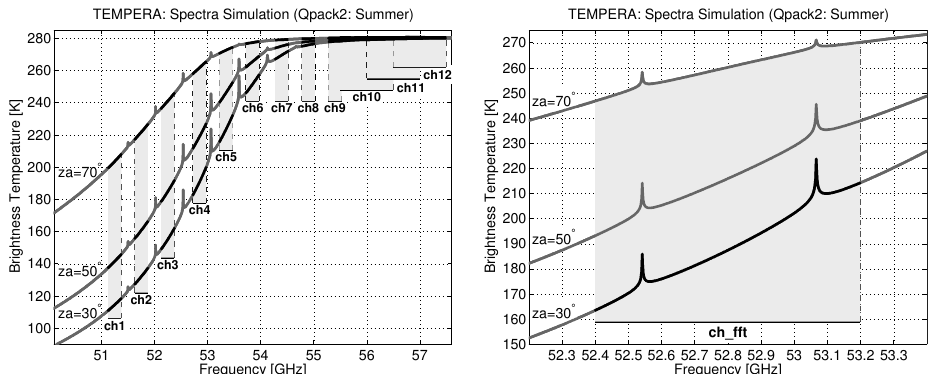
Fig. 3. Left panel: TEMPERA spectrum from 51–57GHz simulated with Qpack2/ARTS2 during summer for zenith angles at 30, 50 and 70 ◦ . The grey bars indicate the 12 channels (ch1–ch12) of the filterbank. Right panel: spectrum from 52–53GHz simulated with Qpack2/ARTS2 during summer for zenith angles of 30, 50 and 70 ◦ ; the grey bar here indicates the available bandwidth of the FFT spectrometer (ch_fft).